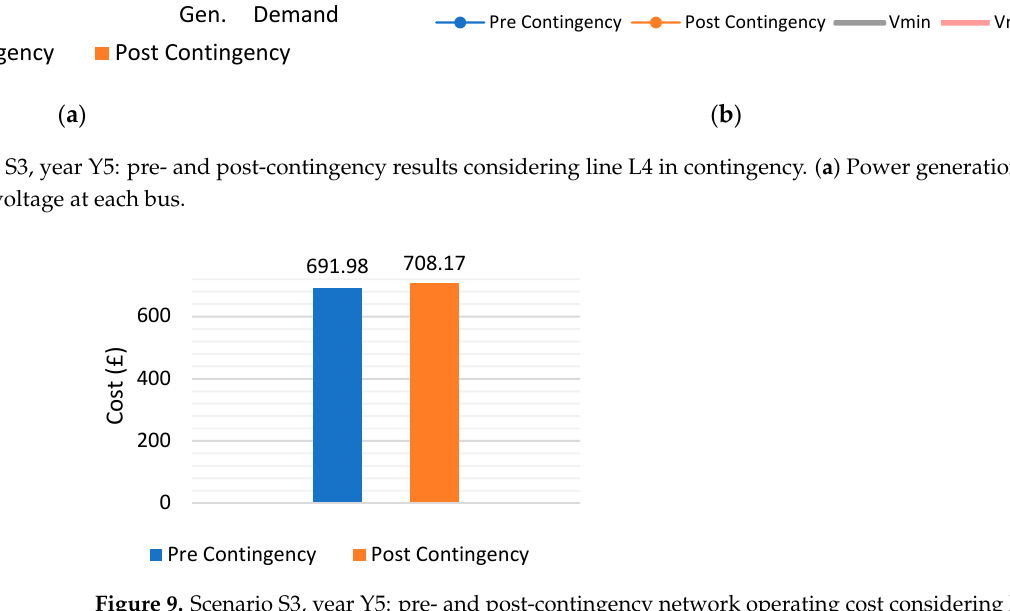
Figure 8. Scenario S3, year Y5: pre- and post-contingency results considering line L4 in contingency. ( a ) Power generation and demand, ( b ) voltage at each bus.